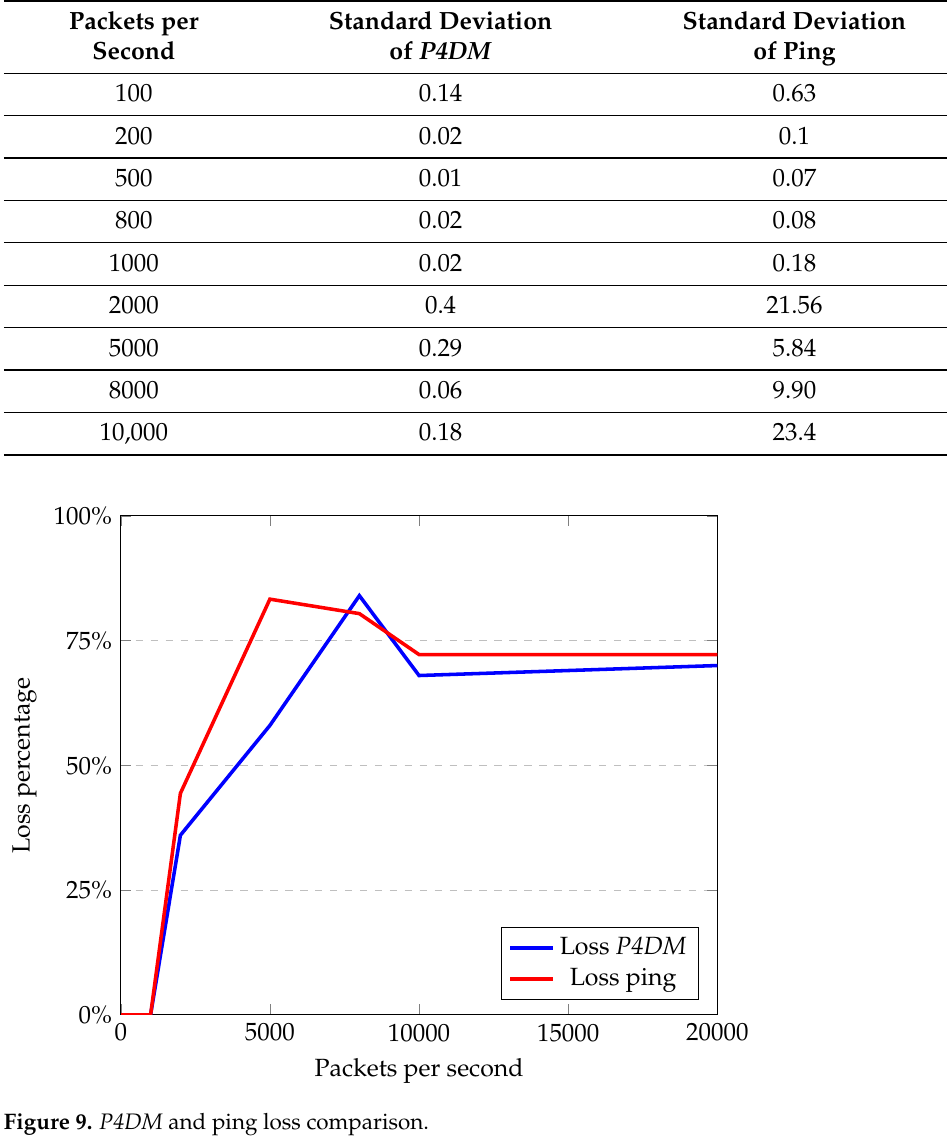
Table 4. P4DM and ping standard deviation